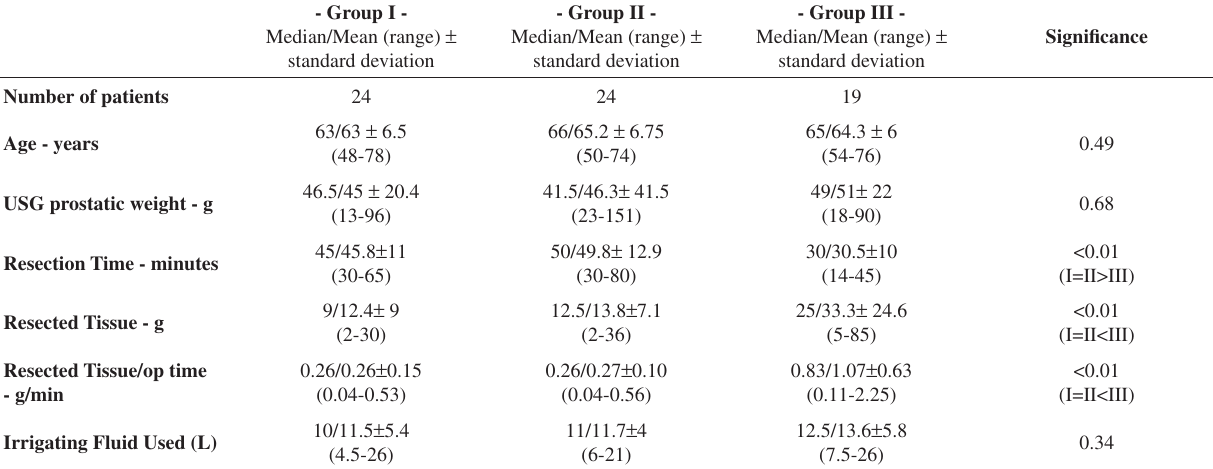
Table 1- Comparison of urologists with different levels of TURP experience